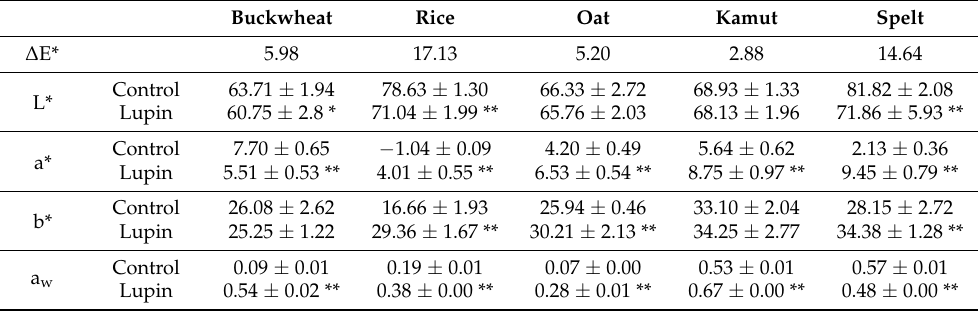
Figure 3. Firmness levels of control and LE cookies 24 h after baking with five different flours. Values are the averages of six experiments ± SD. Note: * represents p < 0.05 and ** represents p < 0.001 when compared with the corresponding control cookie. Table 1. The ∆ E*, L*, a*, b* and water activity (a w ) values for control and LE cookies. Values are the averages of at least five experiments ± SD, except ∆ E*, which is the difference between control and LE cookies. Note: * represents p < 0.05 and ** represents p < 0.001 when compared with the corresponding control